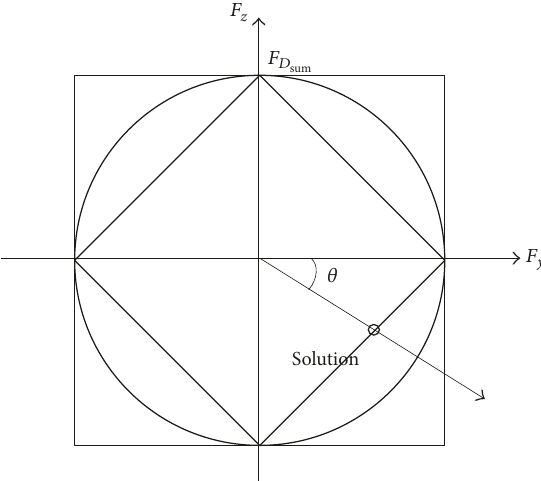
Figure 5: DCS thrust solution with maximized output efficiency.